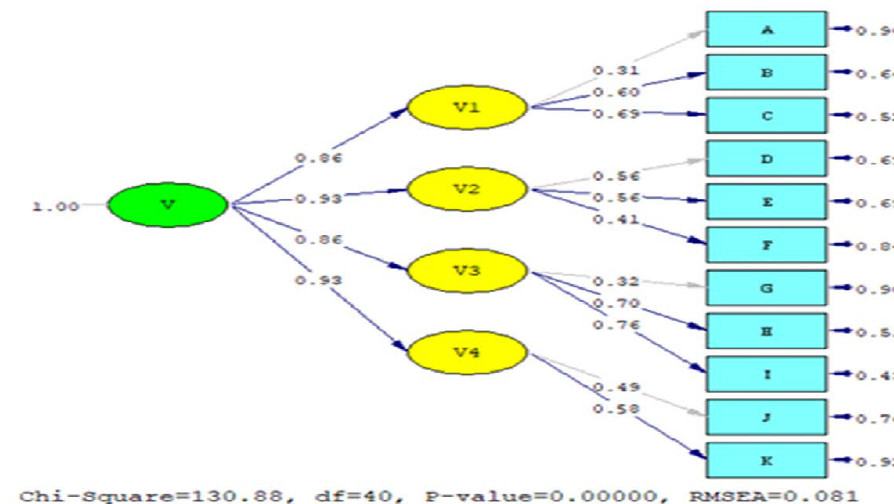
Fig. 3 : Standardized model of confirmatory factor analysis of Lisrel software